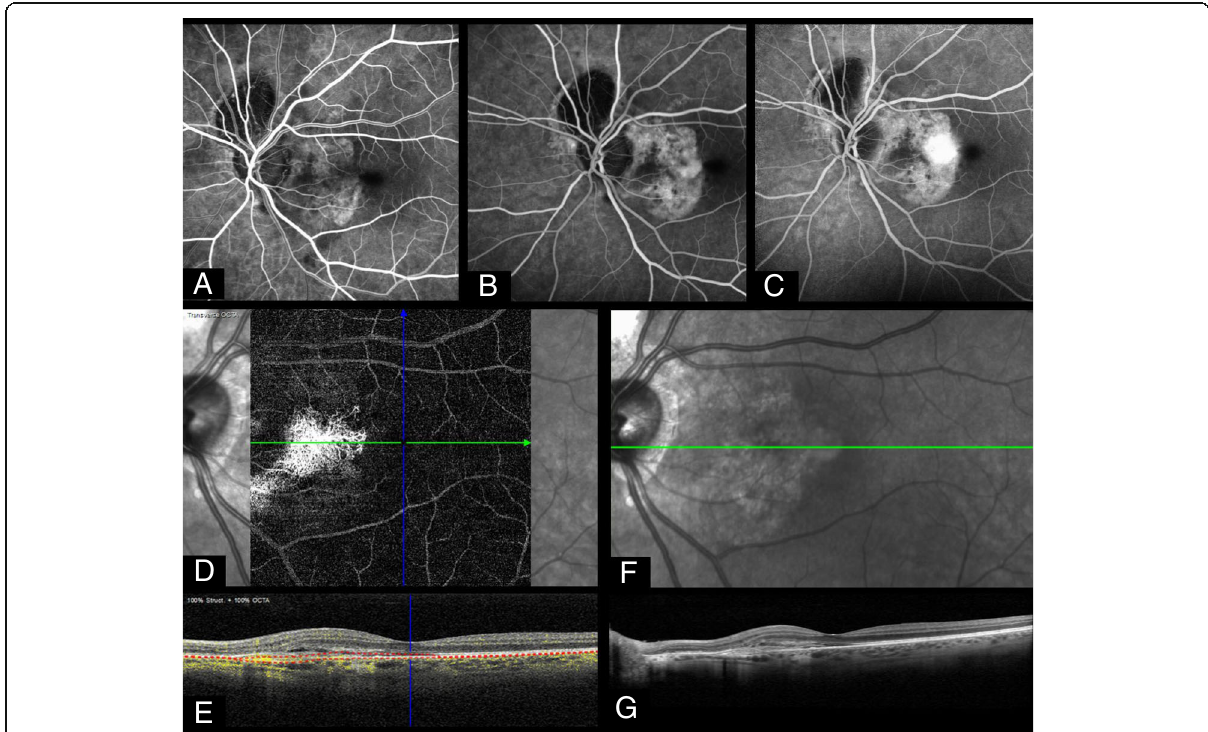
Fig. 2 This 49-year-old lady presented with a 6-week history of reduced vision in the left eye. Visual acuity at presentation was 6/12 in the affected eye, which also showed a chorioretinal scar from a past toxoplasmosis-related chorioretinitis. Fluoresceine angiography revealed a parafoveal spot of active leakage from early- ( a ) through mid- ( b ) to late-phase ( c ). Optical coherence tomography angiography (OCTA) confirmed the presence of a vascular network ( d ) between the retinal pigment epithelium and Bruch ’ s membrane ( e ). Structurally, this corresponded to pigment changes on infra- red imaging ( f ) and subretinal fluid next to a fibrovascular pigment epithelial detachment on OCT ( g